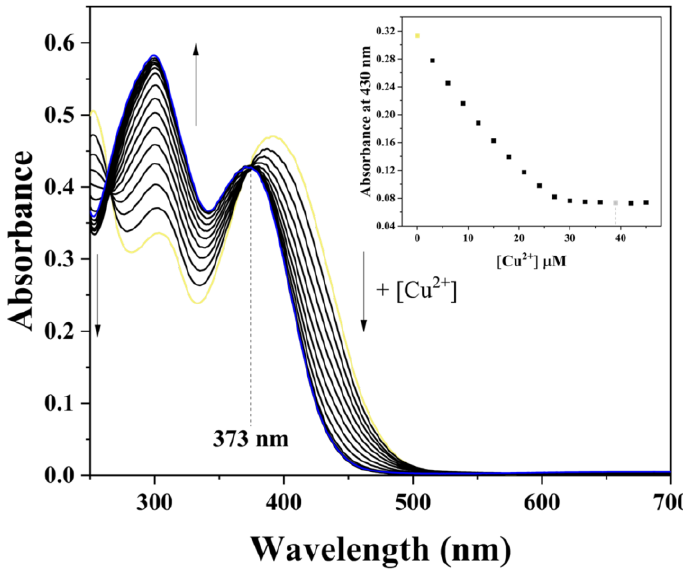
Figure 2. Absorbance spectra of HDHT (30 μM) with different concentrations of Cu 2+ (0 – 45 μ M) (yellow line: HDHT ; blue line: HDHT + 39 μ M Cu 2+ ).